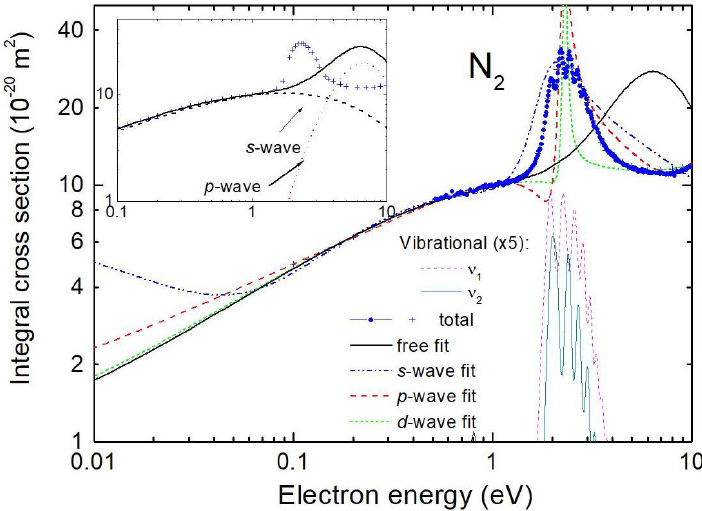
Figure 1. Integral (elastic, vibrational, total) cross sections for electron—N 2 scattering in the low energy range. MERT analysis [39] predicts a shape resonance: its position and width depend on the choice of the low-energy data used as the input for the analysis. Elastic cross sections re-edited from reference [39], vibrational excitation by Michael Allan [42], elaborated in reference [43]. TCS values are taken from reference [10].